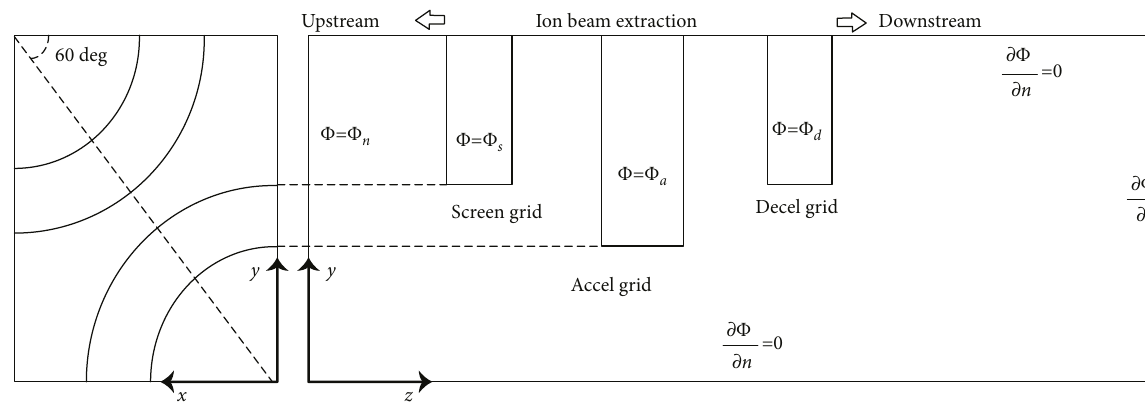
Figure 1: Two-quarter aperture numerical simulation